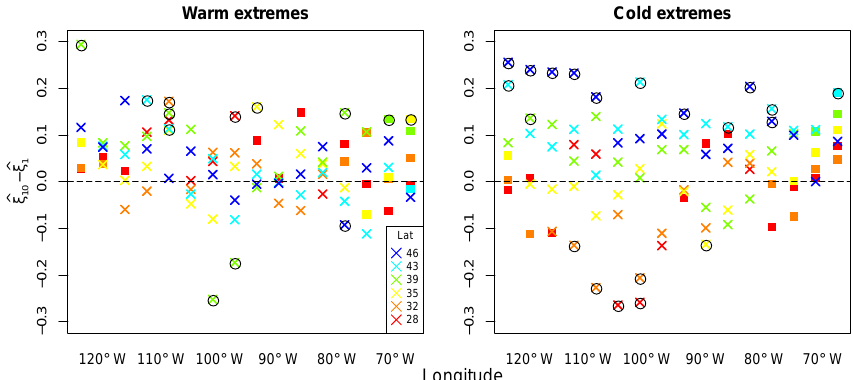
Figure 9. A statistical diagnostic of the assumption that annual blocks are sufficiently long for the GEV approximation. Differences (10- vs. 1-year blocks) in estimated shape parameters are plotted for warm (left) and cold (right) extremes against longitude. Estimates are shown for the pre-industrial climate state, for all model grid cell locations in the study area, with the same color and symbol scheme as in previous figures. Subscripts in notation denote the block length; e.g., ˆ ξ 10 means 10-year blocks. Circled points are those locations where differences in estimates of the shape parameter changes are significant at the 0.05 level based on their bootstrapped p values.